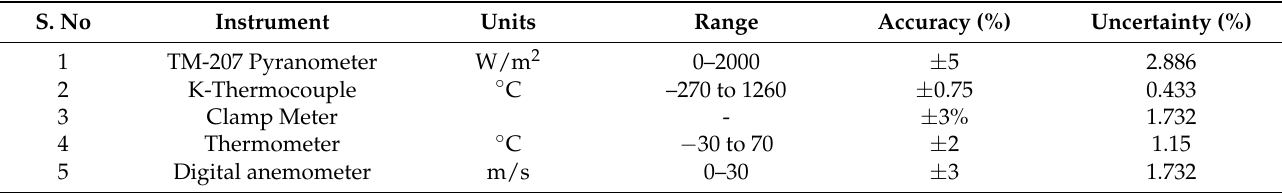
Table 2. Uncertainties of Measuring Instruments [67,81].